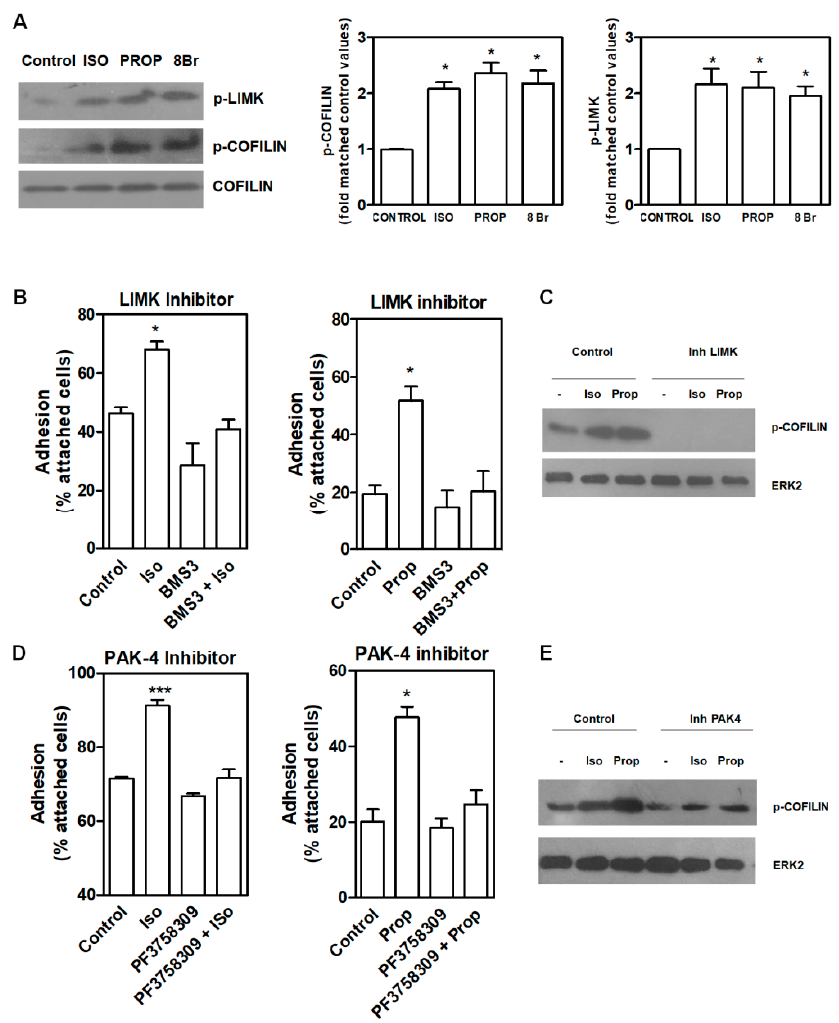
Figure 4. LIMK and COFILIN mediate isoproterenol (ISO) and propranolol (PROP) induced cell adhesion in MCF-10A cells. ( A ) Western Blot of p-LIMK and p-COFILIN after ISO, PROP or the cAMP analog 8Br-cAMP (8Br) treatment. ( B ) Effect of LIMK inhibitor (20 µM BMS-3) on cell adhesion induced by ISO or PROP. ( C ) Western Blot of p-COFILIN after BMS-3 treatment. ERK2 was used as loading control. ( D ) Effect of a PAK-4 inhibitor (10 µM PF3758309) on cell adhesion induced by ISO or PROP. ( E ) Western Blot of p-COFILIN after PAK-4 inhibitor treatment. ERK2 was used as loading control. Statistical significance was assessed using ANOVA Dunnett test. * p < 0.05, *** p < 0.001. Data are representative of three independent experiments.